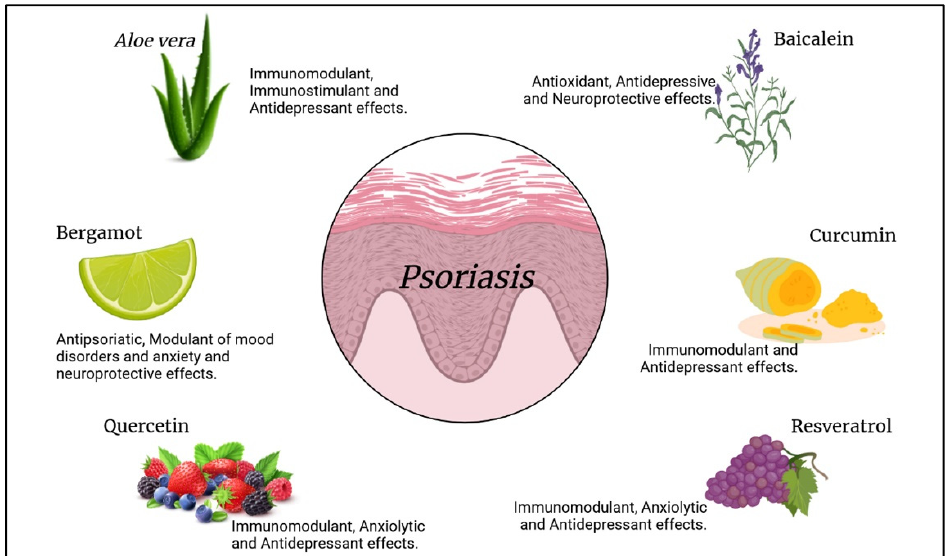
Figure 5. Natural compounds and their effects on psoriasis. Created with BioRender.com (accessed on 14 March 2022).